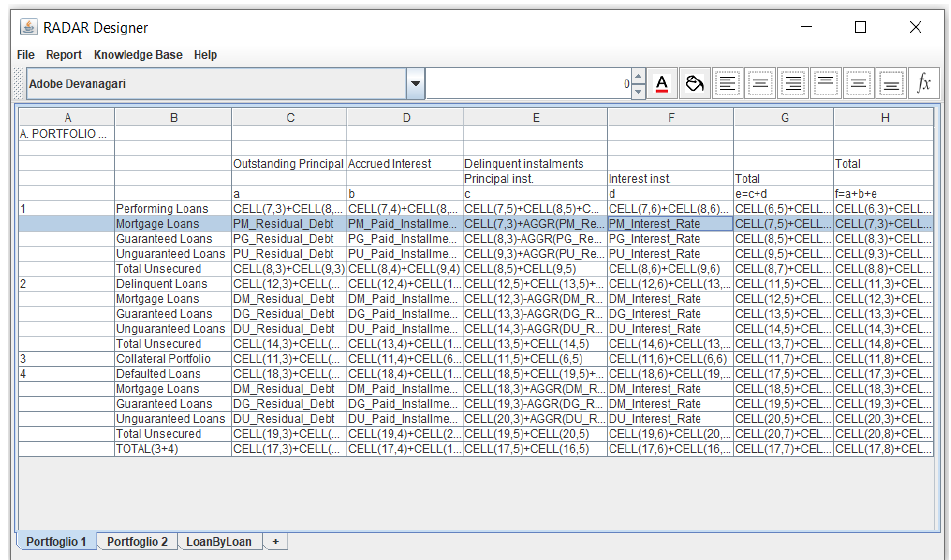
Figure 13. Report Designer : definition of a “aggregation table” in the worksheet called Portfolio1 within a report layout.